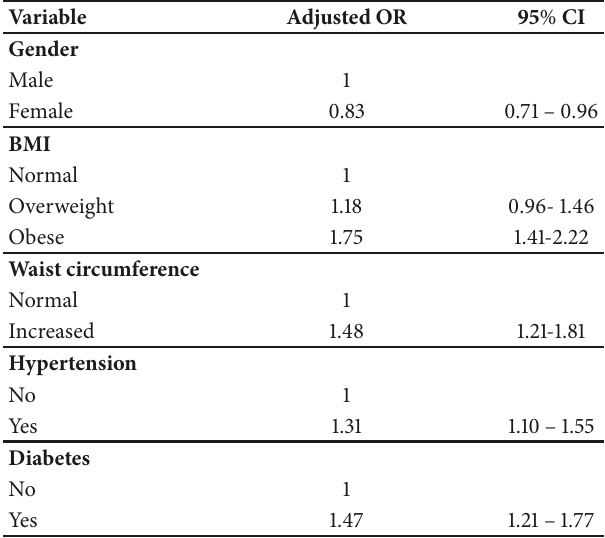
Table4:Adjustedoddsratiosandtheir95%ClforlowHDL-Cusing multivariate logistic regression, Jordan 2017.